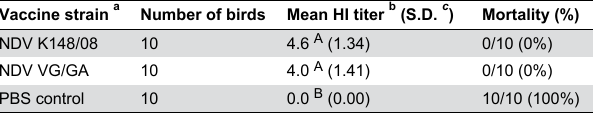
cabinet-type fine sprayer. b Hemagglutination inhibition (HI) test was performed using sera from immunized birds at 14 dpi. Values represented with the same superscript letters for a mean HI titer are not significantly different (p < 0.001 by ANOVA with Tukey–Kramer post- test). c Standard deviation.